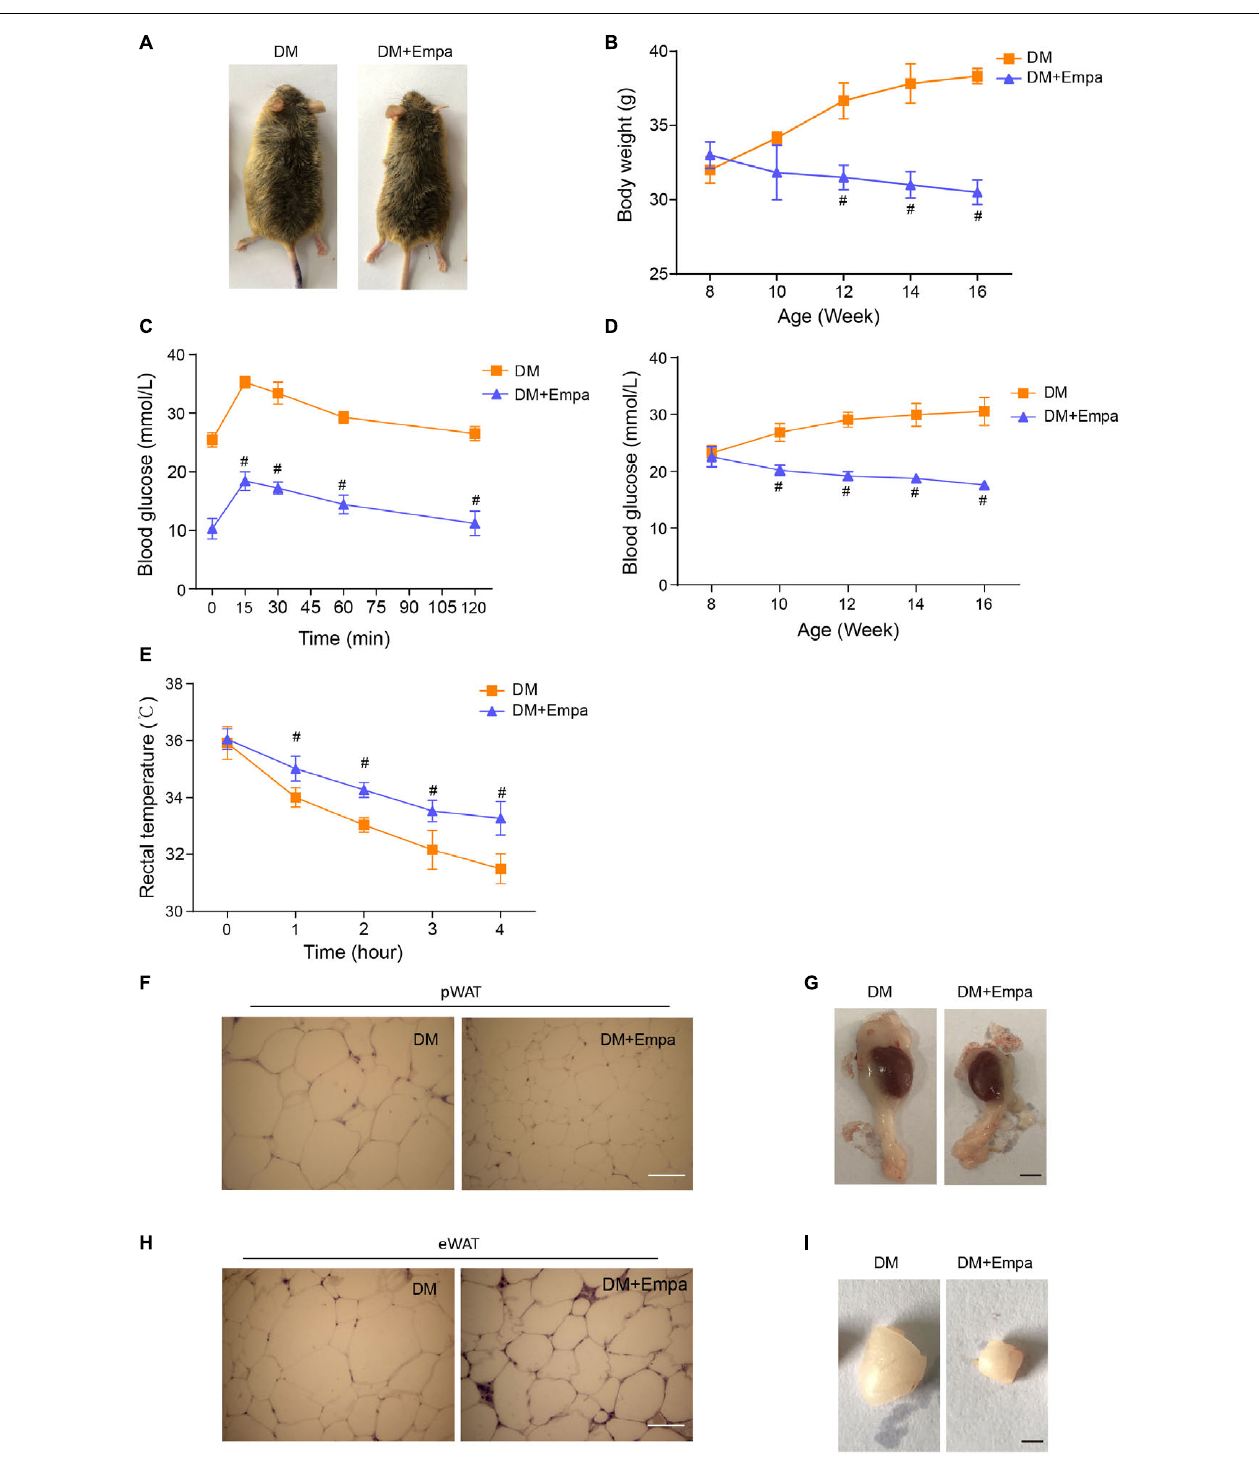
FIGURE 1 | Empagliflozin treatment reduces bodyweight and promotes thermogenesis in KKAy mice. Eight-week-old male KKAy mice ( n = 6 per group) were administered saline (DM) or empagliflozin (DM + Empa) for 8 weeks. (A) Representative images of mice in 2 groups after 8 weeks of treatment; and (B) bodyweights of the mice during 8 weeks of treatment. (C) Changes in blood glucose as detected by IPGTT after 8 weeks of treatment, and (D) postprandial blood glucose levels during 8 weeks of treatment. (E) Body temperature during a 4-hour cold test at 4 ◦ C. (F,H) Representative images of hematoxylin staining, and (G,I) representative images of pWAT and eWAT in mice after 8 weeks of treatment. Scale bar represents 100 µ m in (F,H) and 10 mm in (G,I) . Data are presented as the mean ± SEM. # P < 0.05 vs. the DM group. pWAT, perirenal white adipose tissue; eWAT, epididymal white adipose tissue. IPGTT, Intraperitoneal glucose tolerance test.